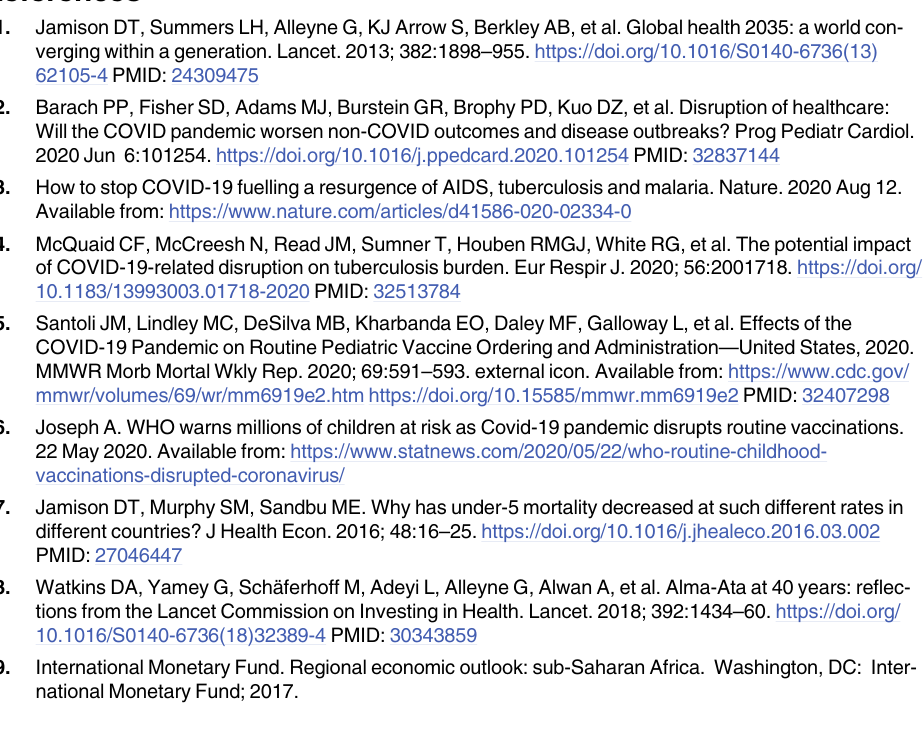
S2 Table. AARC between 2009 and 2019 used in the estimation. AARC, average annual rate of